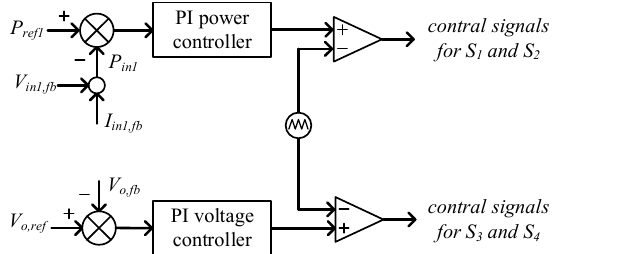
Figure 11. Control block diagram of the proposed converter.